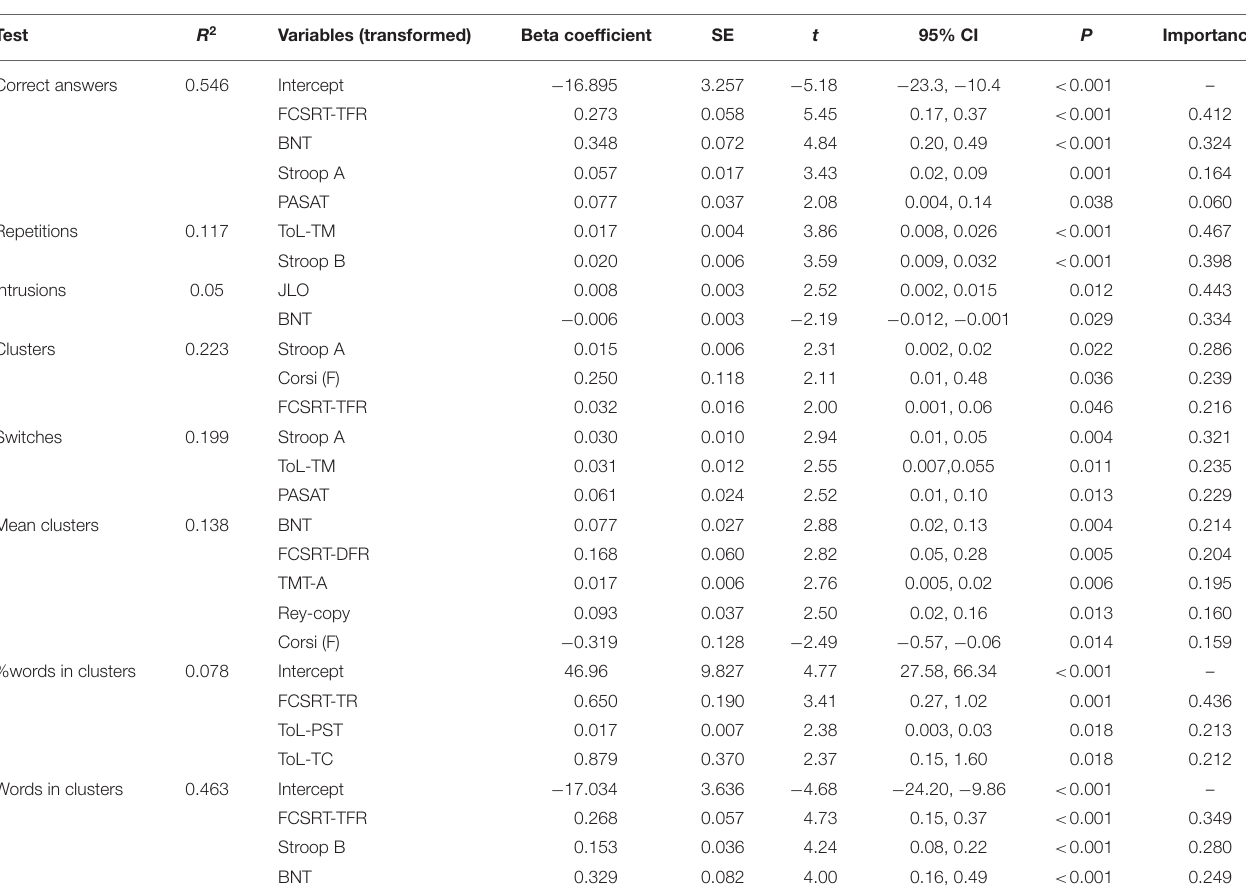
TABLE 3 | Automatic linear modeling assessing the neuropsychological predictors of semantic